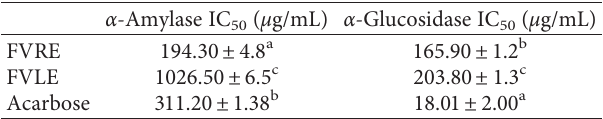
Figure 3: Percentage of α -glucosidase inhibition versus different concentrations of F. vulgare leaf and rootstock aqueous extracts. Table 3: IC 50 values of FV aqueous extracts on α -amylase and α -glucosidase inhibition.